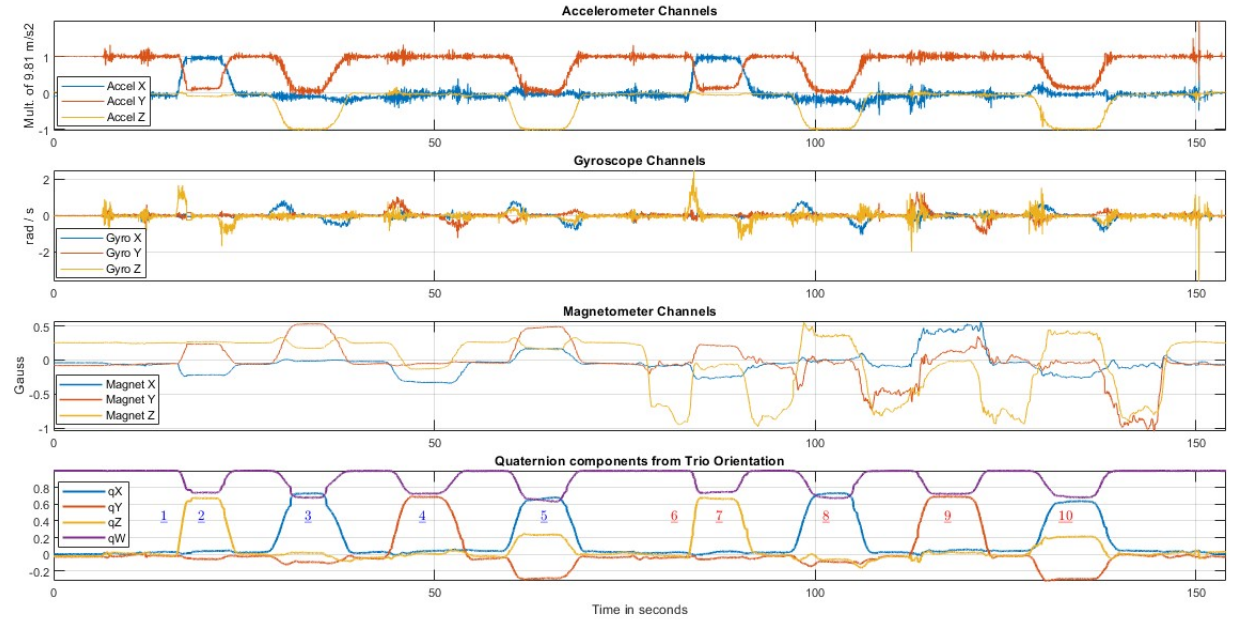
Figure 3. From top to bottom: plot of the three accelerometer channels; plot of the three gyroscope channels; plot of the three magnetometer channels; and temporal evolution of the four components of the rigid body orientation estimate from the Trio system as a quaternion. (Underlined numbers indicate the